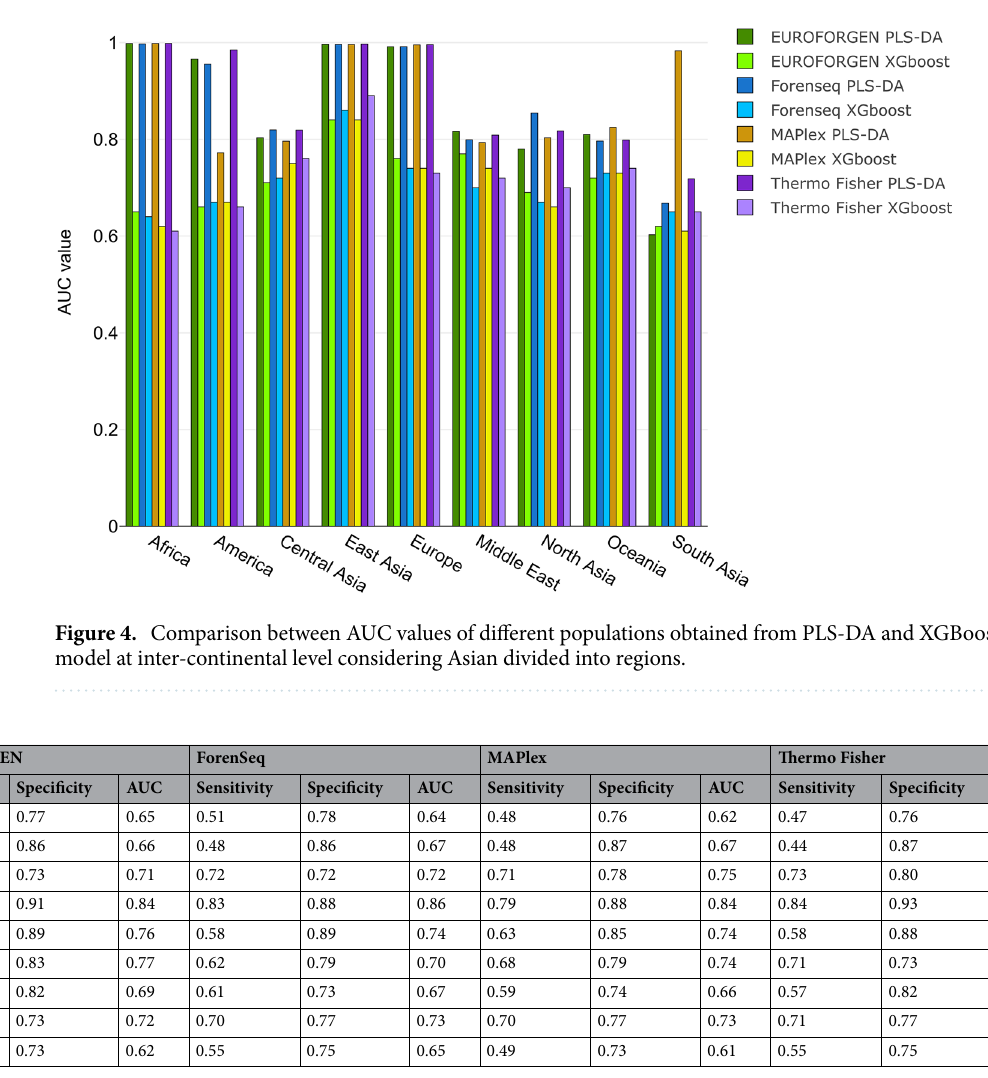
Table 1. Sensitivity, specificity, and AUC values of the optimal XGBoost model built at inter-continental level for all panels